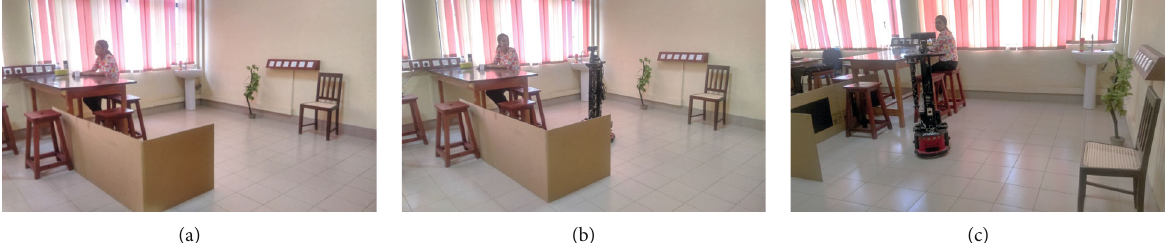
Figure 6: An example scenario during the experiment is shown. (a) The user was in the kitchen, having a drink, (b) the robot approached user and initiated a conversation, and (c) interaction continued.